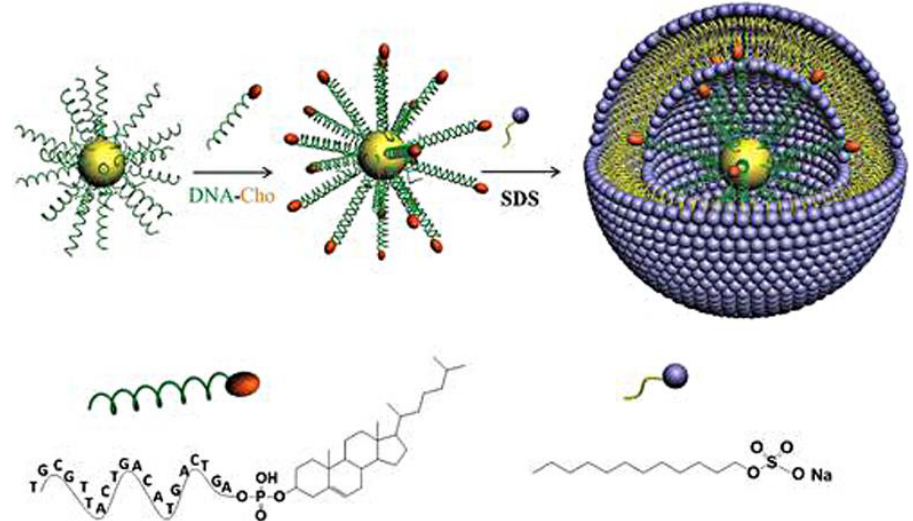
Figure 2. Schematic of formation of hetero-vesicles through the frame guided assembly process.